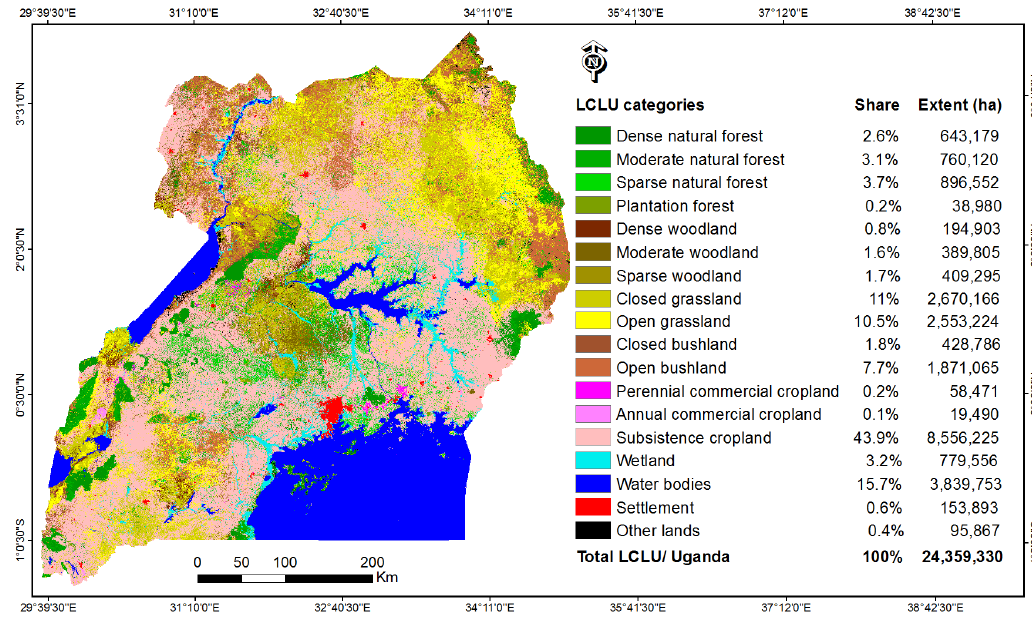
Figure 3. Land cover and land use (LCLU) map of Uganda in 2014.